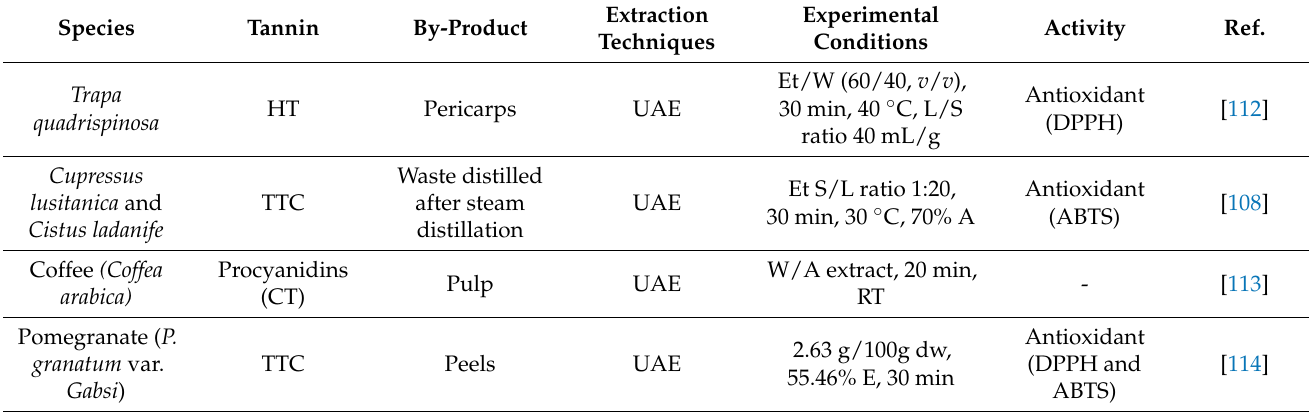
Table 3. Examples of tannin extraction techniques from different agri-food by-products. Extraction Experimental By-Product Techniques Conditions